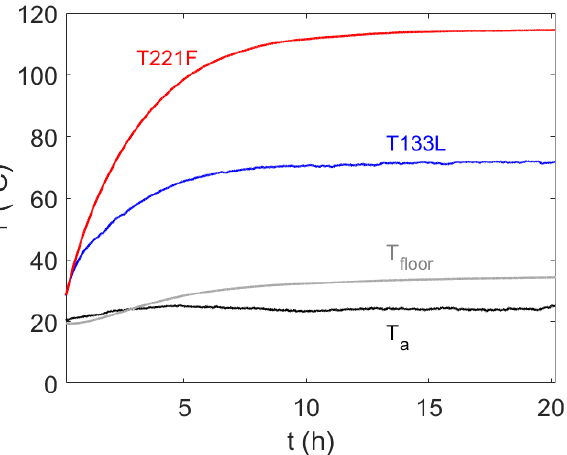
Figure 8. Time evolution of the maximum, minimum, wood bottom, and ambient temperature measured by the thermocouples in the